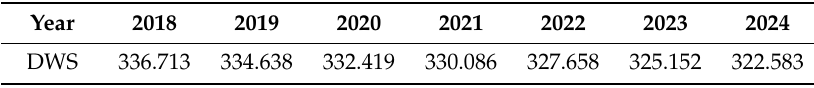
Table 4. Prediction data of the discharge amount of waste-sewage water(DWS) into Yangtze River basin during basin during 2018–2024.